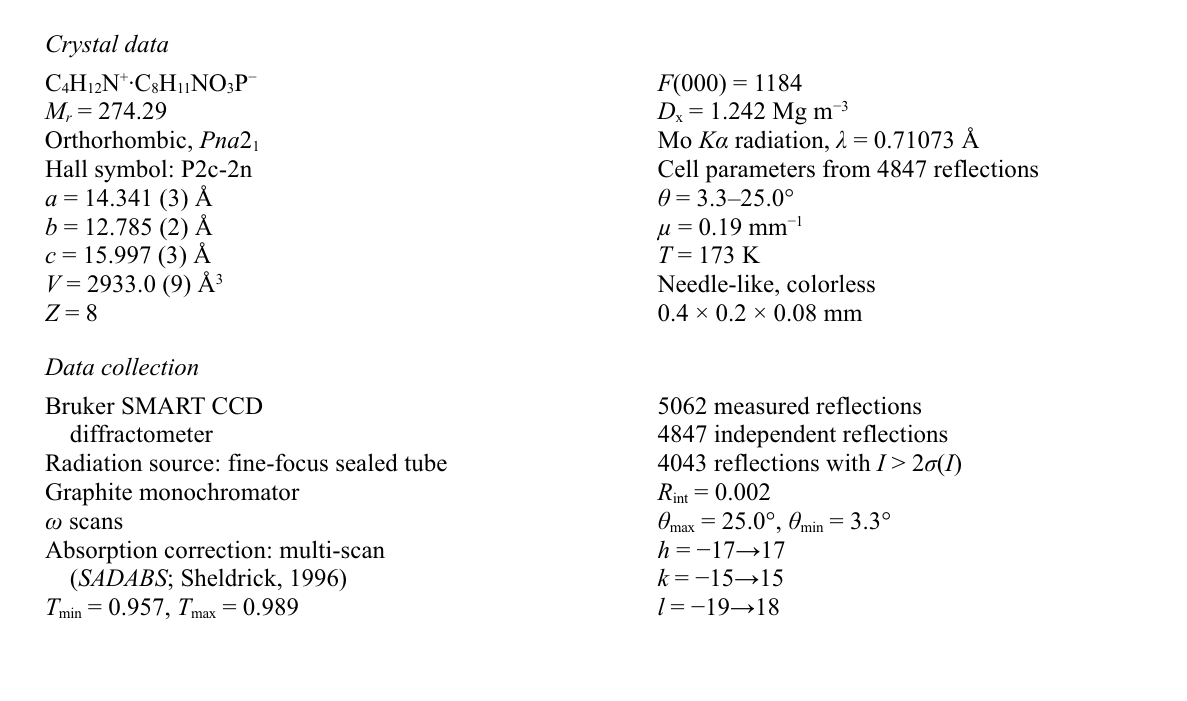
Figure 2 The packing of (I), viewed down the b axis, showing the N—H···O hydrogen bonds between the diethylamine cations and the N -ethoxy phosphoryl-phenylamide anions. H-atoms have been omitted for clarity. Diethylammonium